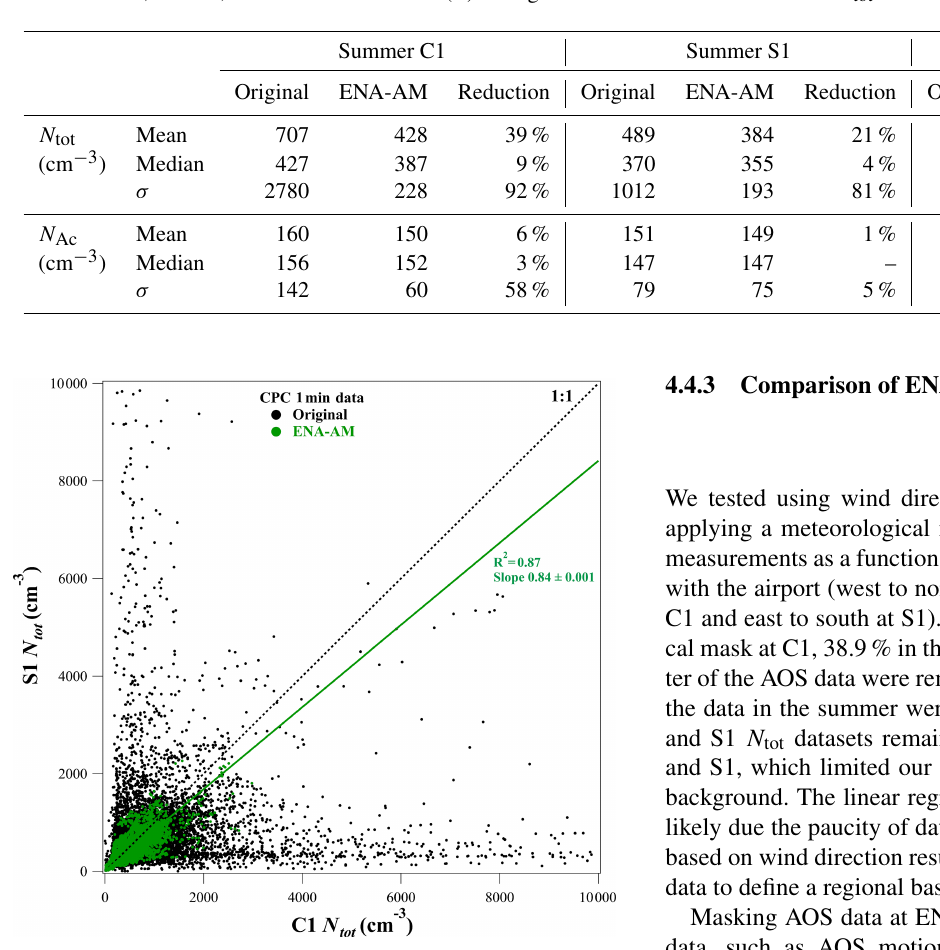
Table 3. Mean, median, and standard deviations ( σ ) of original and ENA-AM masked 1min N tot at C1 and S1 during the summer and winter.